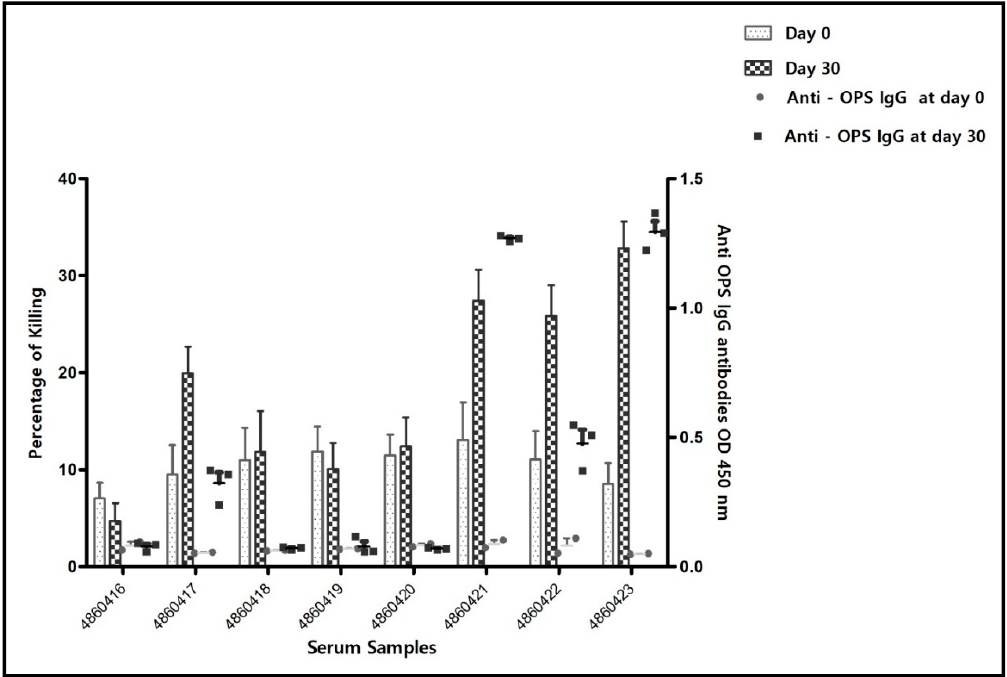
Figure 2. Percentage of cell killing of B. melitensis 16M cells by the individual serum samples on day 0, prior to vaccination and day 30 post-vaccination period, along with development of anti- Brucella OPS i-ELISA titers respectively (results obtained in the second set of experiments). i-ELISA results are of one experiment in triplicates . SBA results represent data of percentage of cell killing from 4 experiments, each including duplicates. Bars stand for standard error of mean.